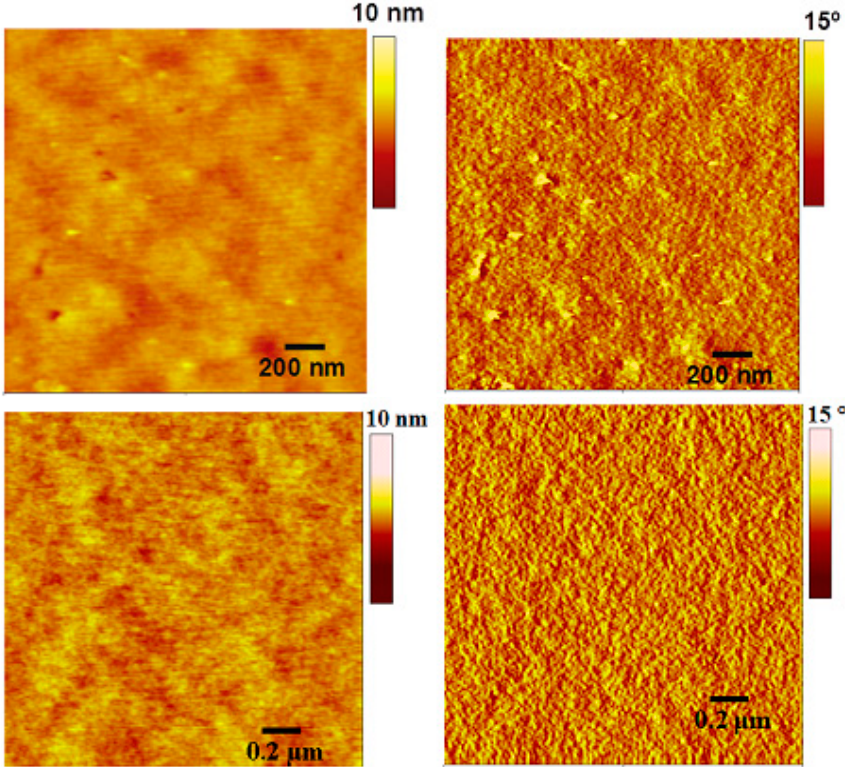
Figure 9. AFM images of 1:1 blends of AS2 ( top ) and AS1 ( bottom ) with PC 61 BM as-casted from chlorobenzene solution. Topographic ( left ) and phase images ( right ) are shown.